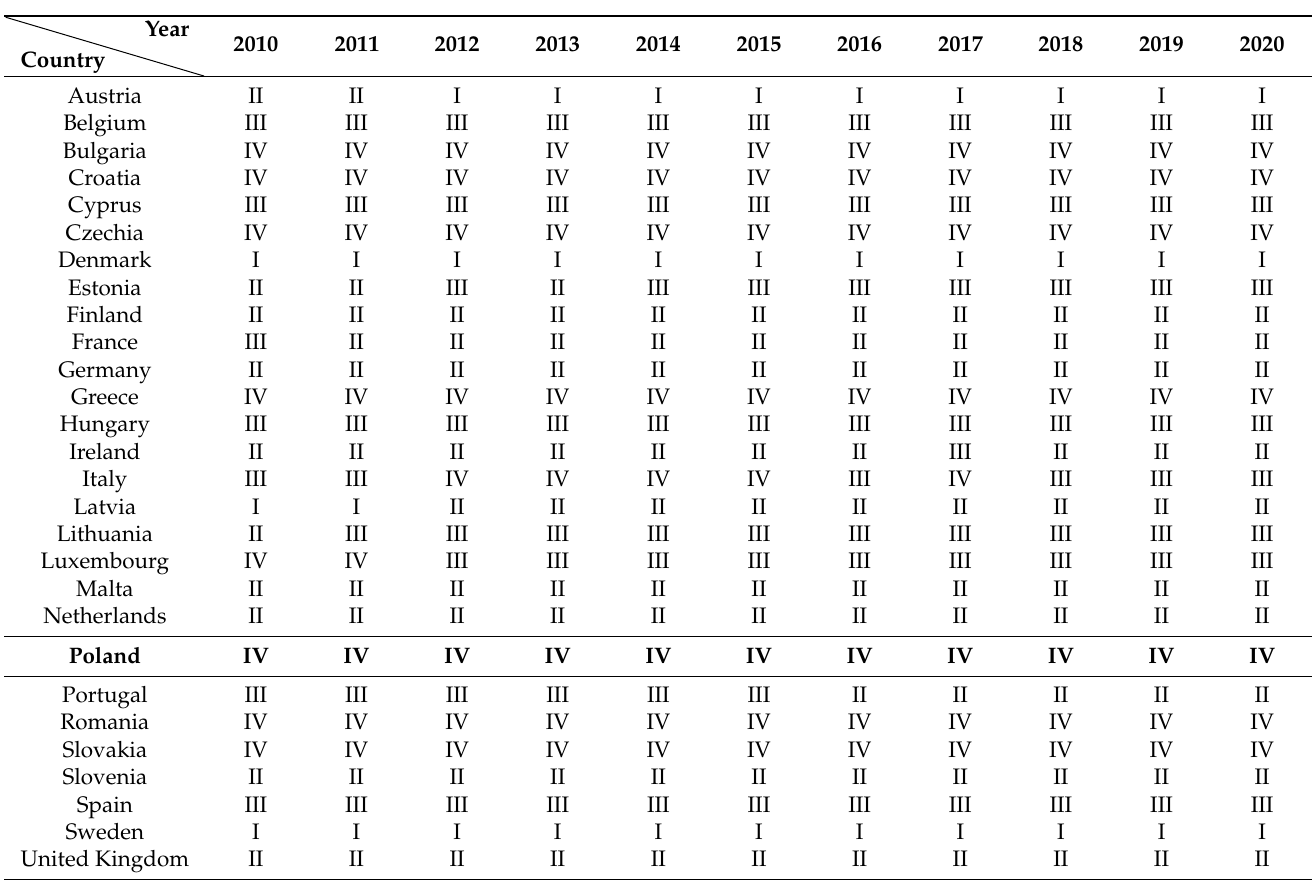
Table 6. EI—grouping of EU-28 countries in